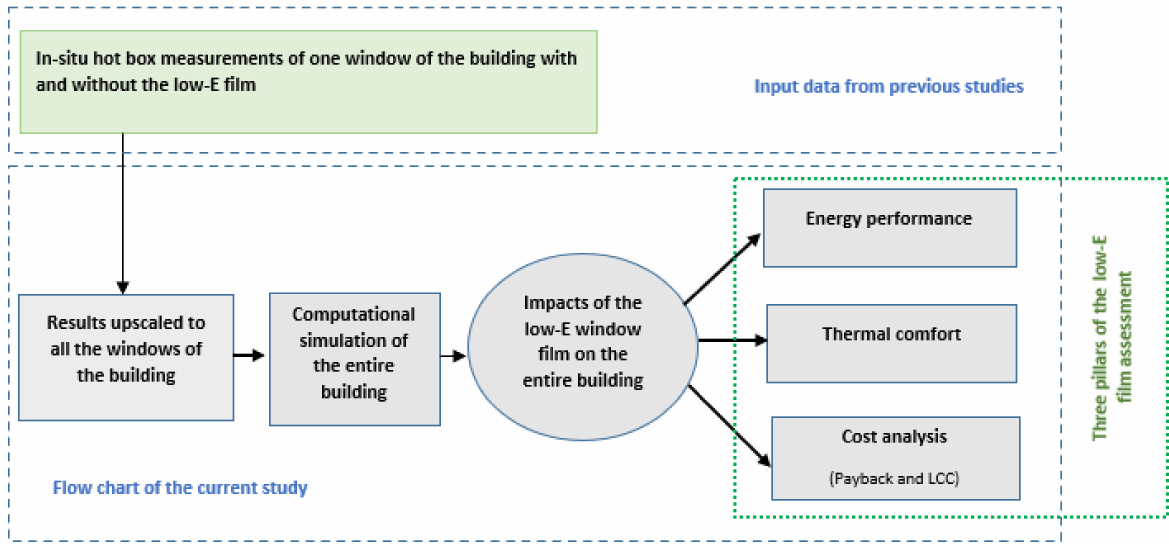
Figure 2. Flow chart of the current